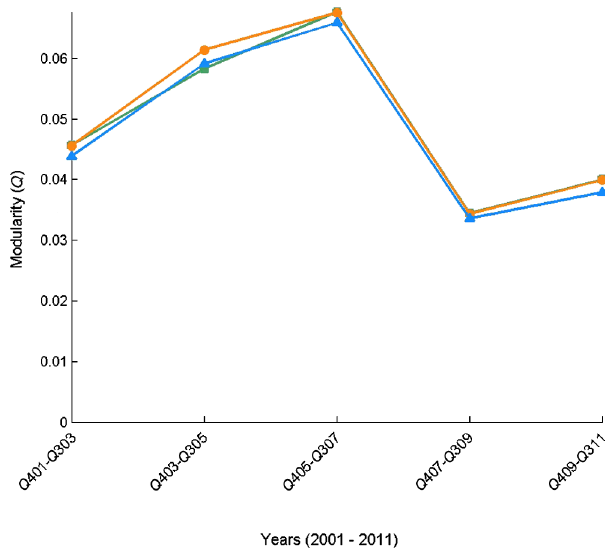
FIG. 16. Temporal trend in the values of Q 3 ð ~ σ (cid:4) Þ for the different methods over a two-year sliding window spanning the time frame from October 2001 to October 2011. (The Potts method is shown by green squares, the Louvain method by orange circles, and the spectral method by blue triangles.)